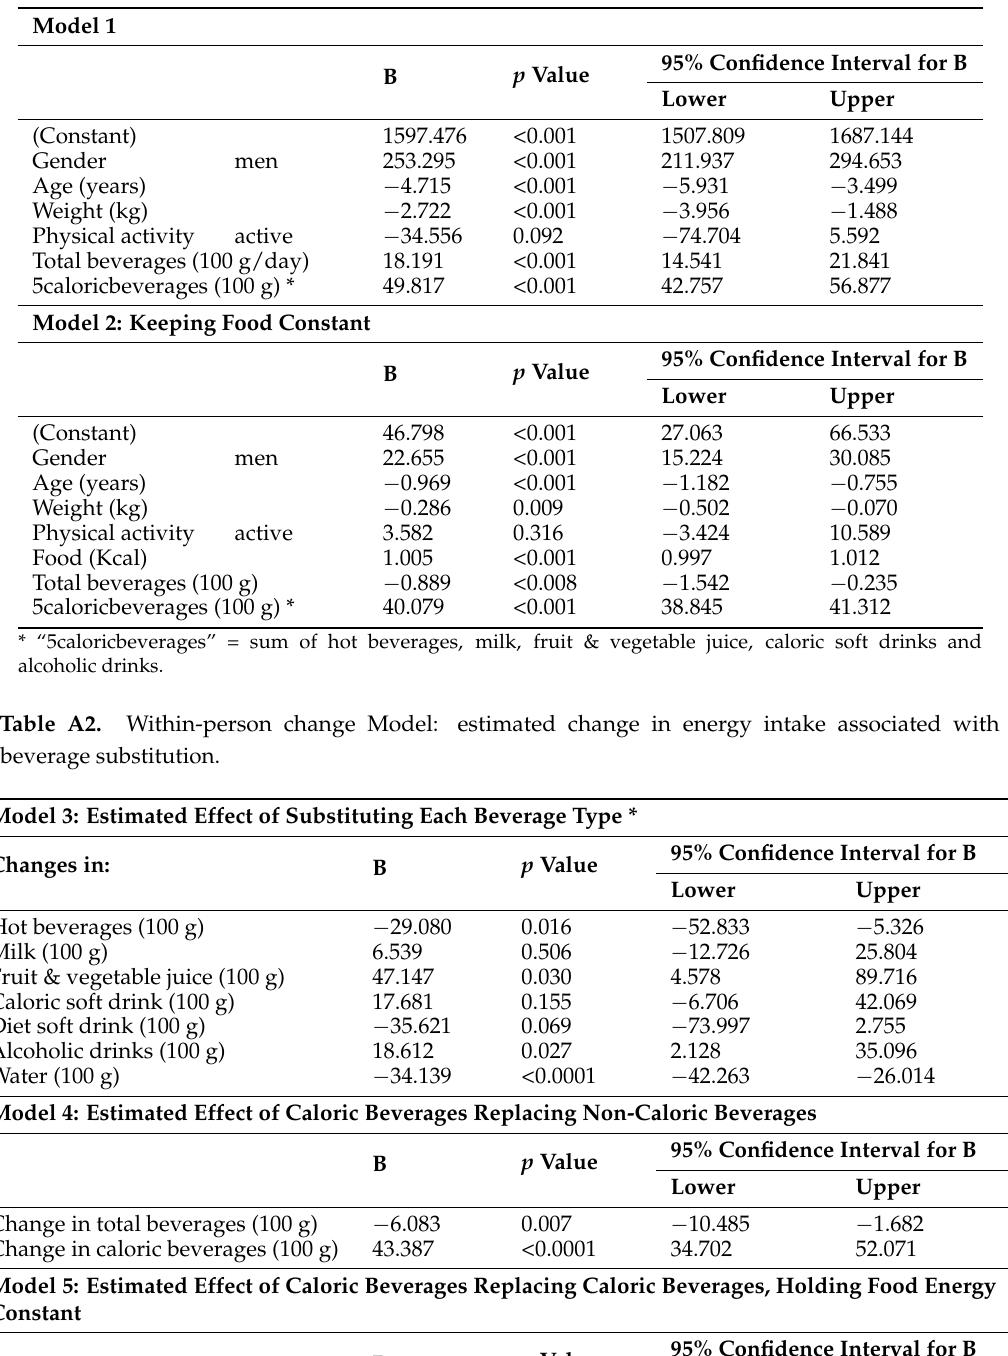
Table A1. Regression model estimating change in energy intake associated with adding caloric beverages in place of non-caloric beverages.